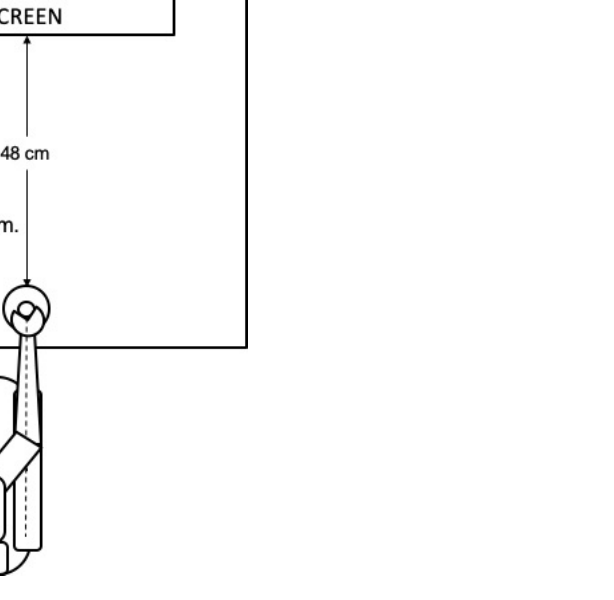
Figure 2. Participant position and instrument distribution during the performance of the task.